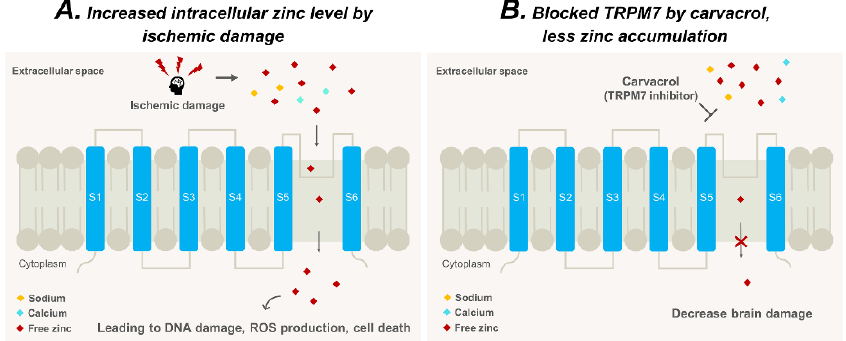
Figure 5. This schematic illustration indicates carvacrol action via inhibition and downregulation of the TRPM7 channel. ( A ) Ischemic brain insult causes an increase in extracellular sodium, calcium, and free zinc levels. These ions could be moved into the intraneuronal space via various proton-sensitive cation channels, such as the acid-sensing ion channel (ASIC), the N -methyl- D -aspartate receptor (NMDAR), and transient receptor potential melastatin 7 (TRPM7). In particular, the TRPM7 channel mediates zinc ion regulation. ( B ) Carvacrol administration inhibits intraneuronal zinc accumulation via the TRPM7 channel. Because of this agent’s mechanism, zinc accumulation is decreased by inhibiting TRPM7, resulting in decreased hippocampal neuron death after an ischemic insult.